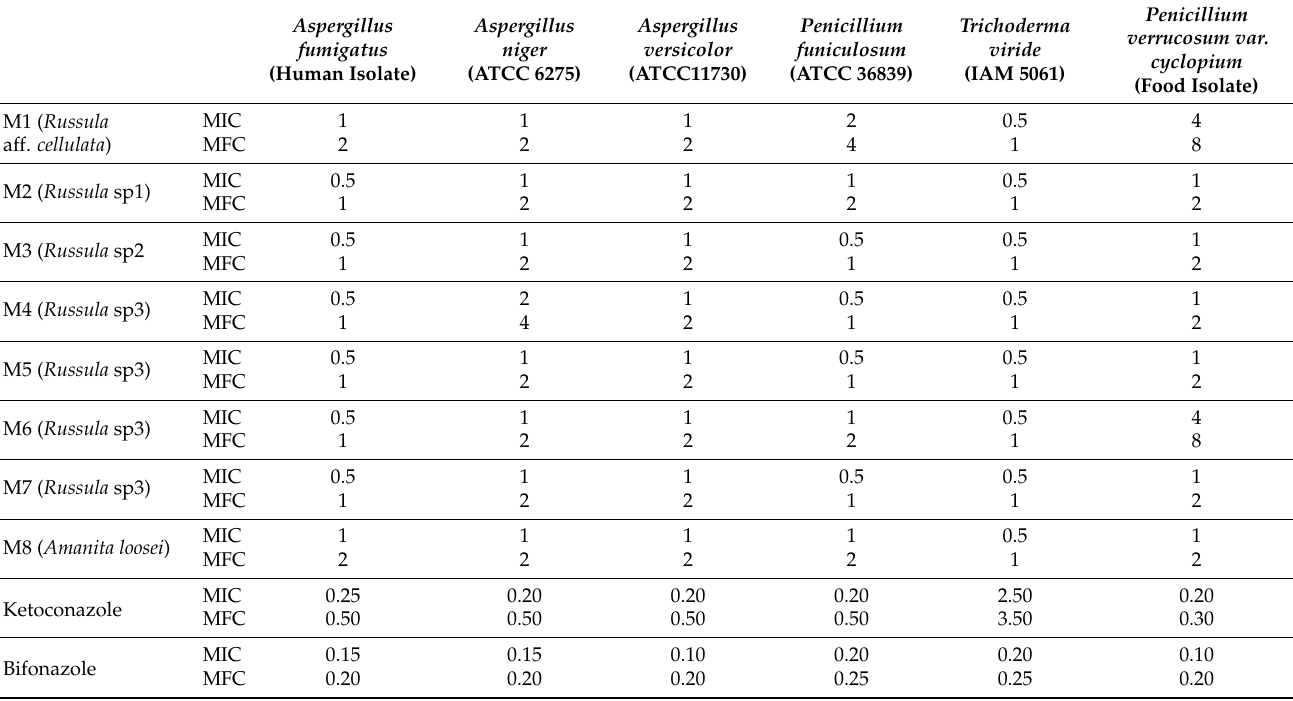
Table 5. Antifungal activity of studied mushrooms hydroethanolic extracts